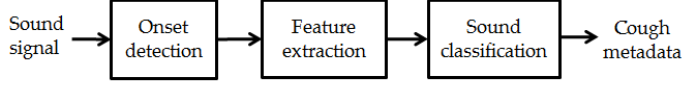
Figure 15. Pipeline used for detecting cough events in the sound signal.